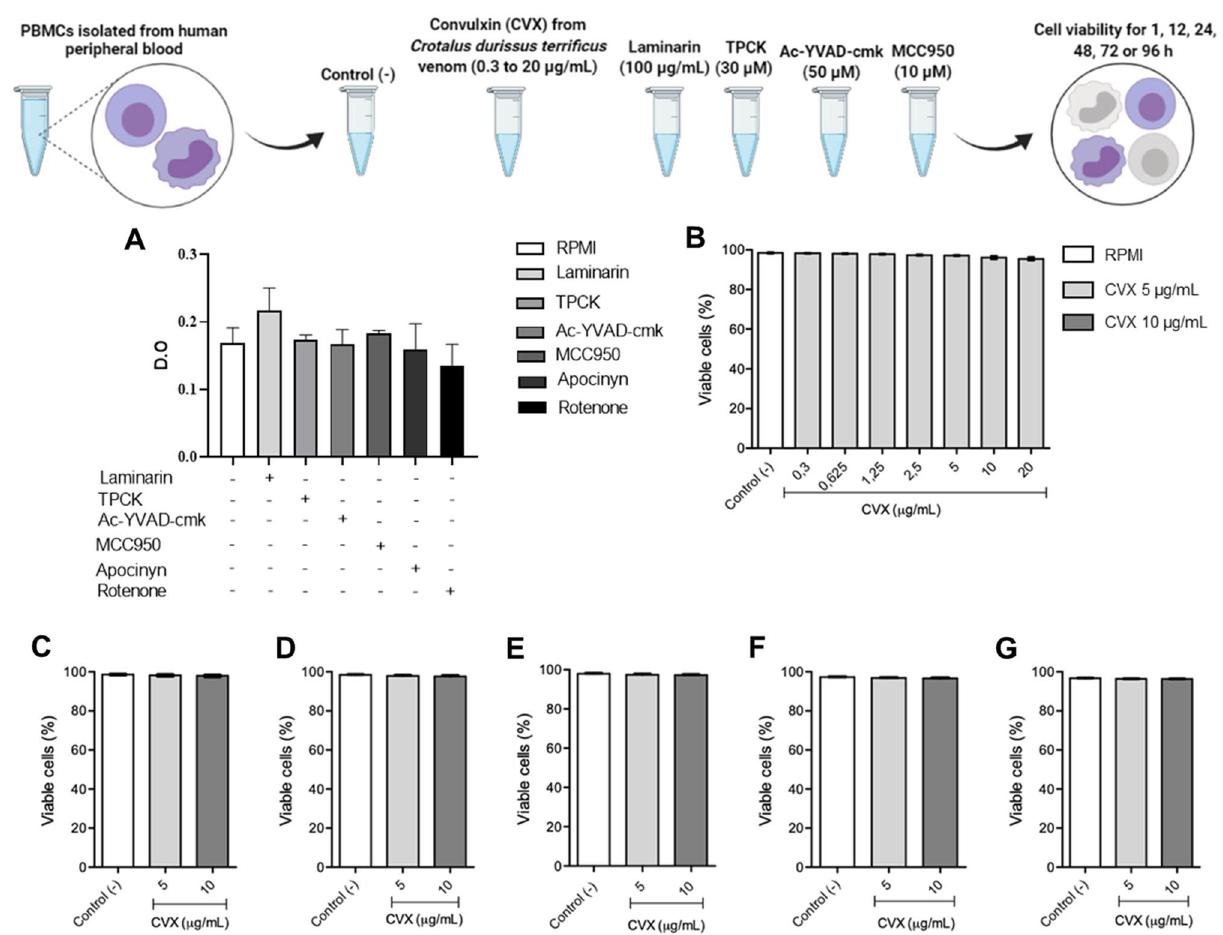
Figure 1. Cell viability of PBMCs in the presence of Convulxin (CVX). Human PBMCs isolated from leukocytes from healthy adult blood donors by a density gradient method viability in the absence or presence of inhibitors was measured by MTT metabolization method ( A ). Isolated 2 × 10 5 PBMCs were incubated with RPMI (control) or with different concentrations of CVX (0.3 to 20 μg/mL; experimental group) for 1 h ( B ), or CVX (5 and 10 μg/mL; experimental group) for 12 ( C ), 24 ( D ), 48 ( E ), 72 ( F ), and 96 h ( G ). Viability was then assessed by PI and TO method in FACScan. The results were expressed in % and represent the mean ± S.E.M. from 4 to 5